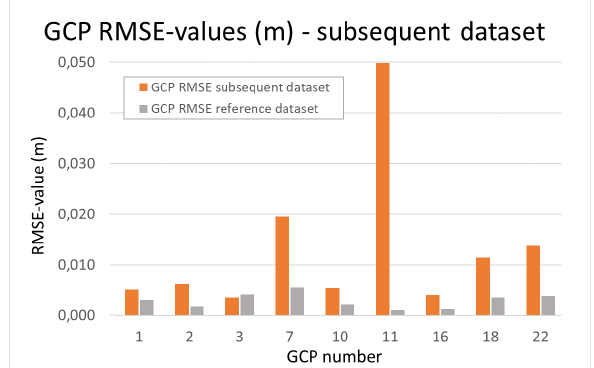
locations in the pictures. The medians of the various GCPs range from 0,25 to 1,05 px.